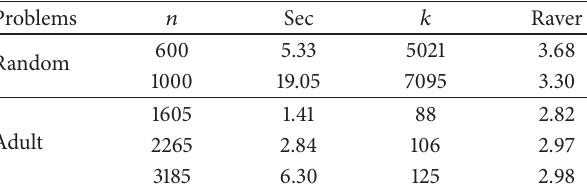
Table 2: Numerical results for Algorithm 5. Problems 𝑛 Sec 𝑘 Raver